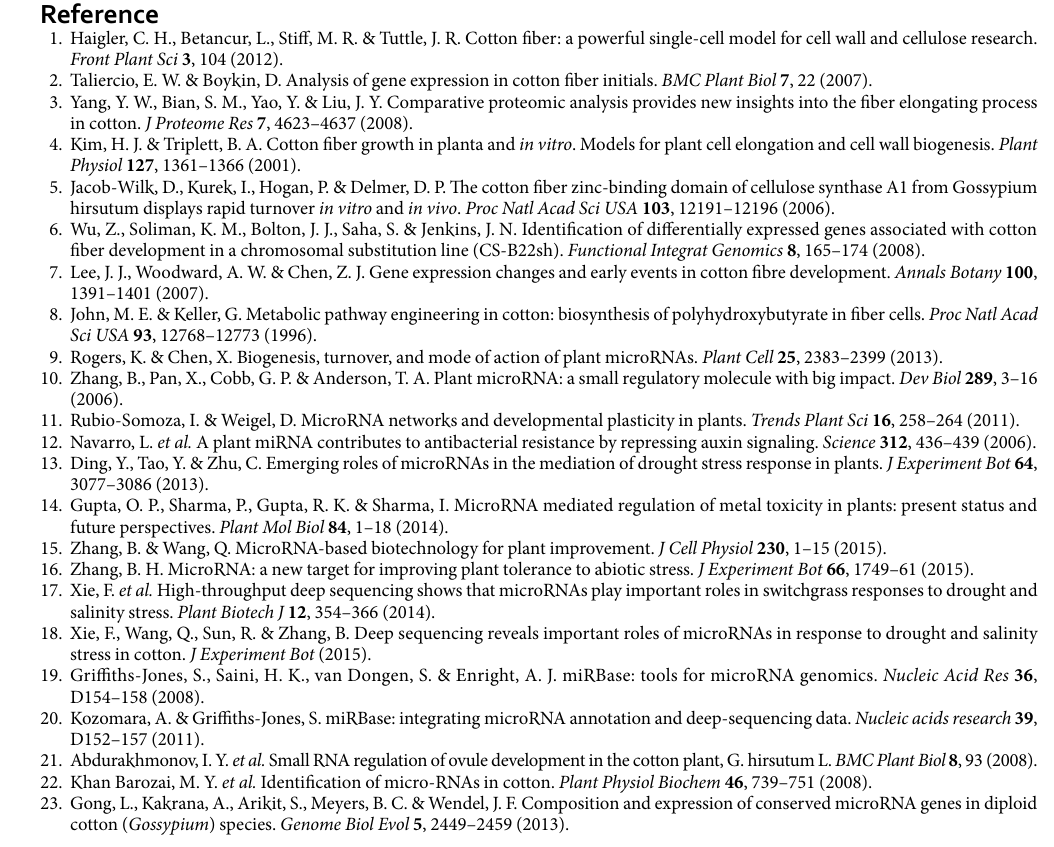
involve in fiber development. We also provided the GO-based classification and KEGG pathway enrichment of tested miRNAs. This study provides a comprehensive comparison of 54 miRNA expression profiles during multi- ple developmental stages of cotton fiber initiation and development, which may provide the potential regulatory roles in cotton fiber development.